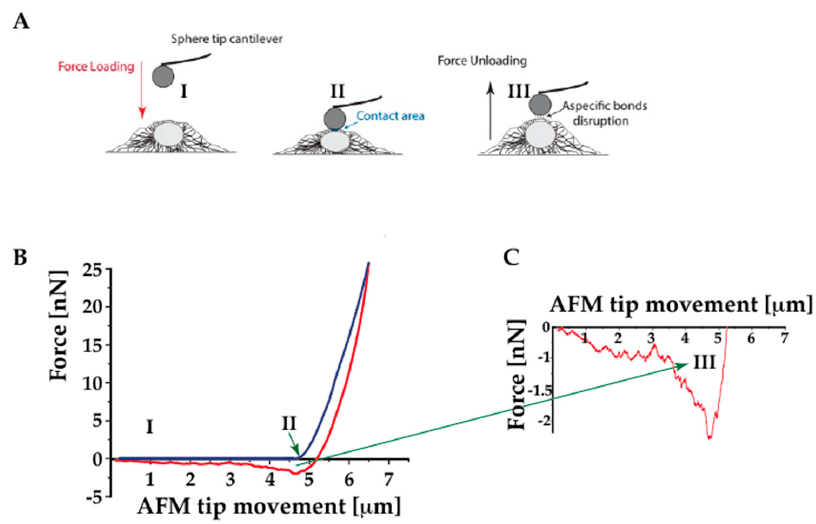
Figure 4. Introduction to the AFM force spectroscopy work for assessing adhesion behavior. ( A ) experimental setup of AFM force spectroscopy performed on the cell using a sphere tip; ( B ) sketch of the components of a F-D curve; ( C ) enlarged plot of the F-D retract part of the curve providing the adhesion data.